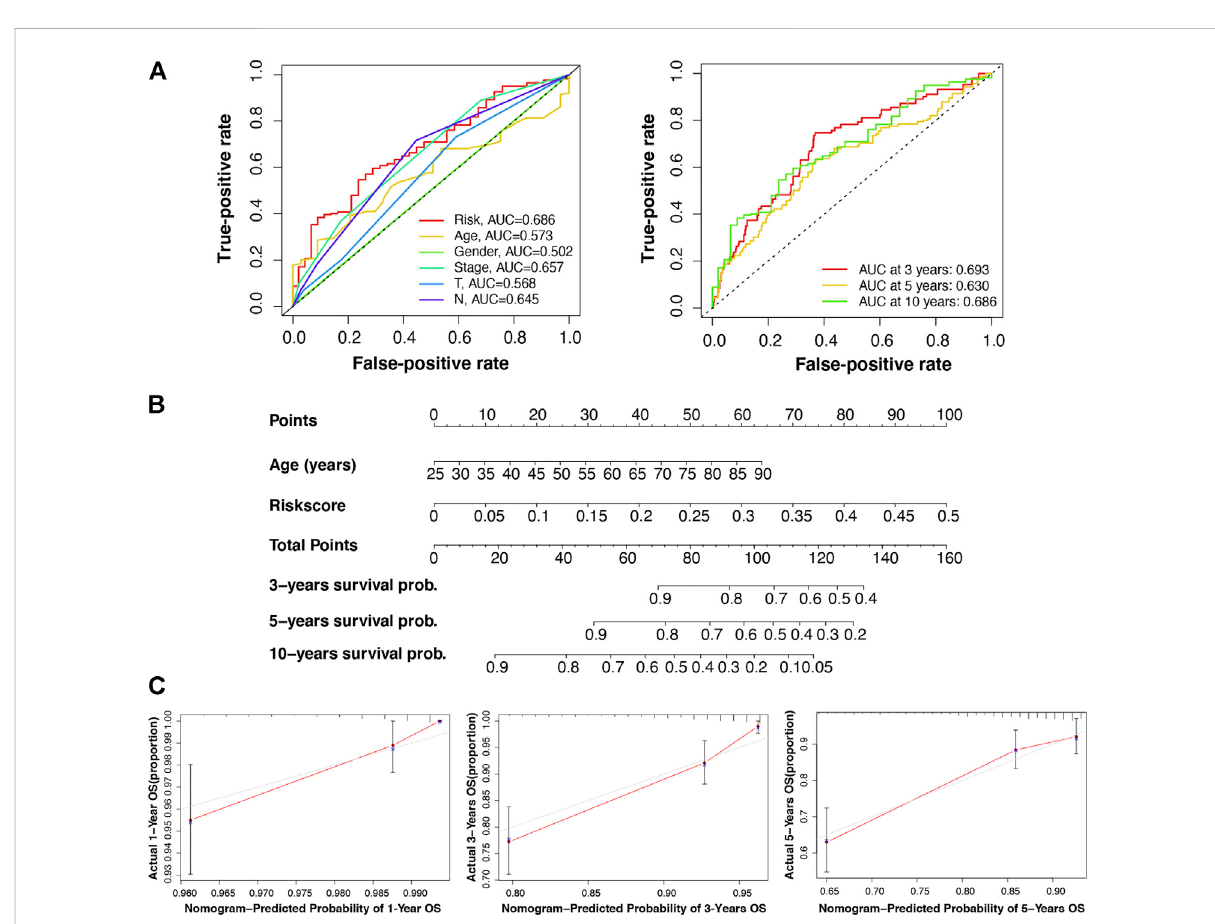
FIGURE 5 Validation of the reliability of the m7G-LPS and development of the nomogram. (A) Receiver operating characteristic curve of m7G-LPS and clinicopathological factors. (B) The nomogram developed based on the independent prognostic factors of age and risk score to predict the 3-, 5-, and 10-year survival rates. (C) The calibration plots of the nomogram were measured to evaluate the predicted probabilities of the nomogram.